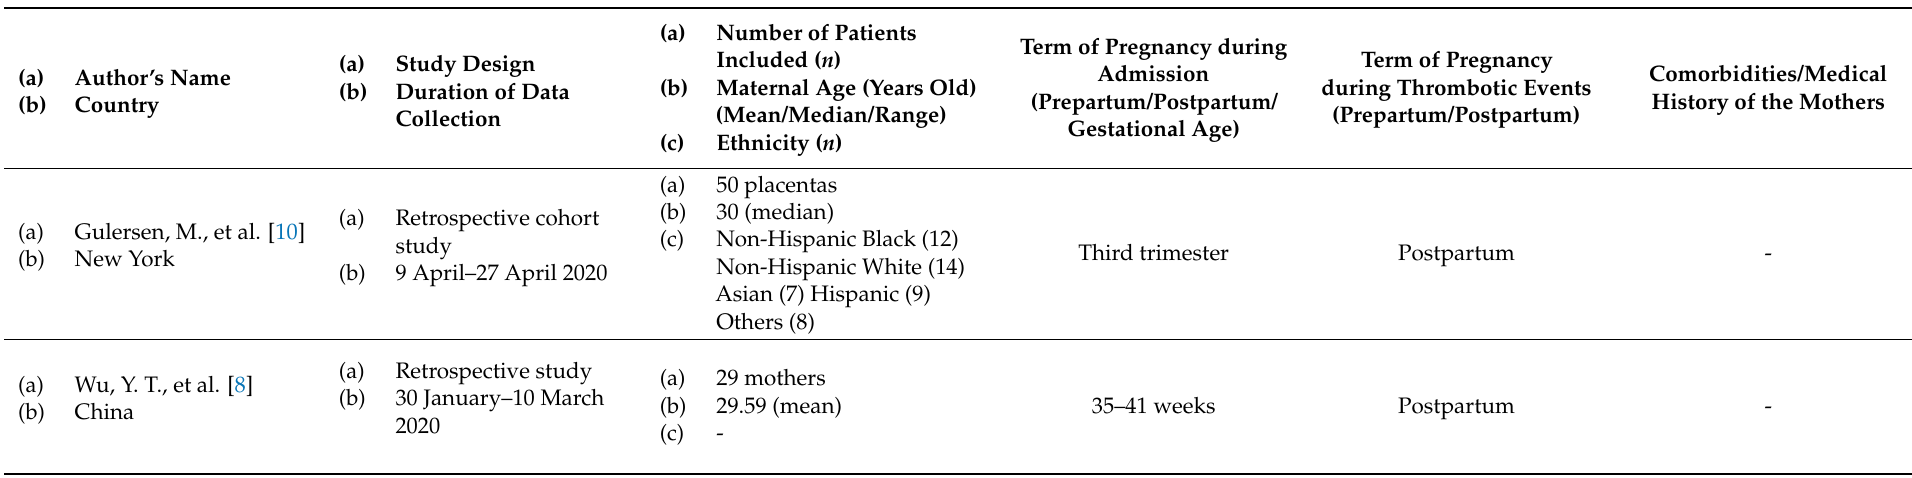
Table 2. Demographics characteristics of retrospective/prospective/cohort studies reporting thromboembolic (TE) complications among pregnant women infected with